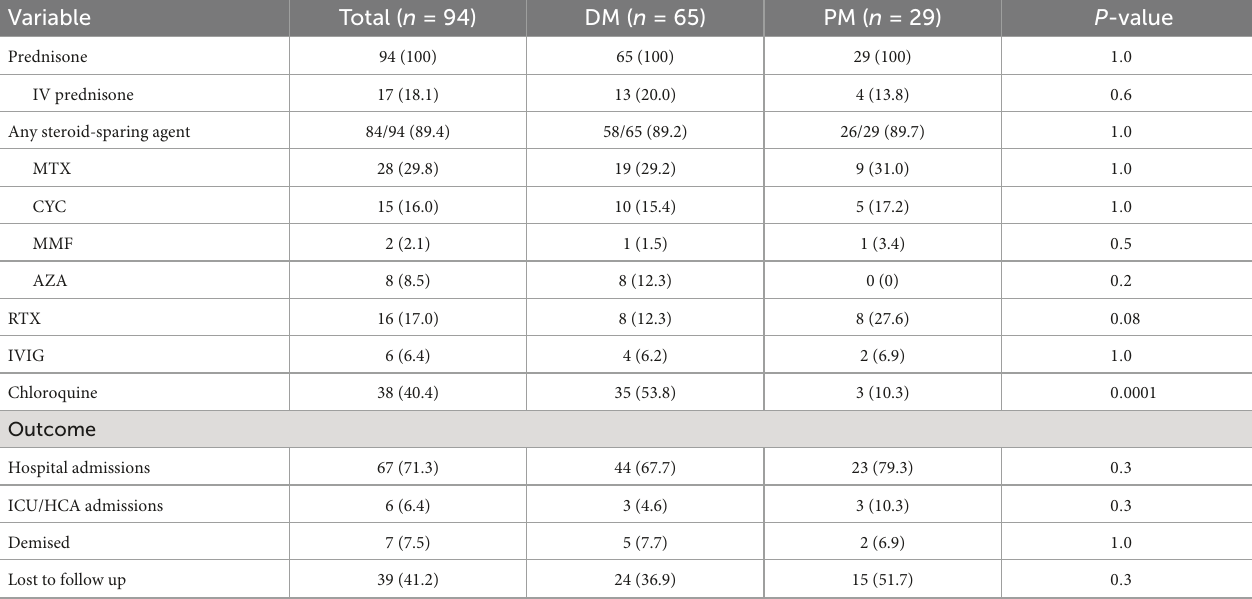
TABLE 3 Immunosuppressive therapy and outcomes in 94 patients with idiopathic inflammatory myopathy.